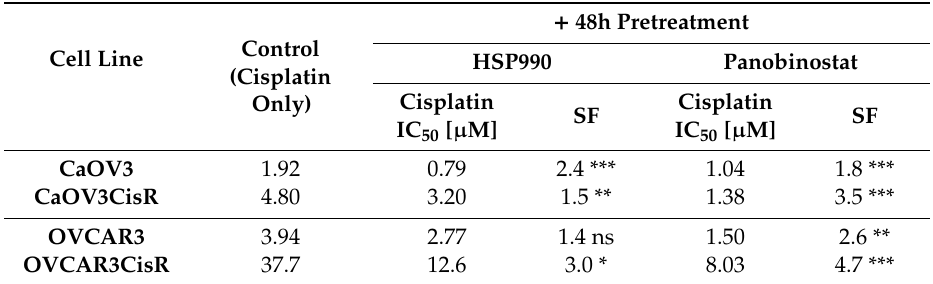
Table 4. Influence of dual combinations with panobinostat or HSP990 on the cytotoxic activity of cisplatin in CaOV3, OVCAR3, and their cisplatin resistant sublines.